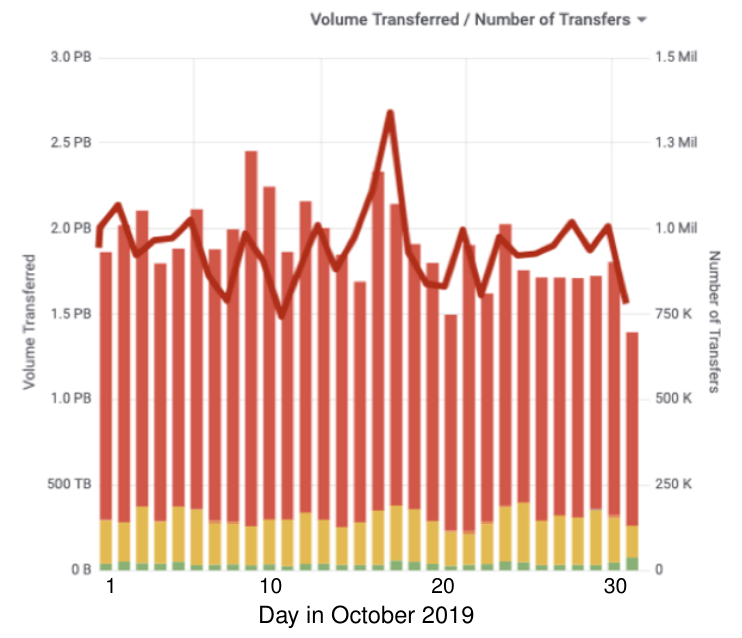
Figure 1. Current CMS data transfer requirements. This bar graph shows one month of data transfers for CMS, one bar per day. Red and yellow show the bandwidth used by PhEDEx (di ff erent versions) while green shows the bandwidth used for user transfers. The solid red line shows the number of files transferred per day, approximately one million. User transfers are a comparable number of files as PhEDEx, but much smaller average file